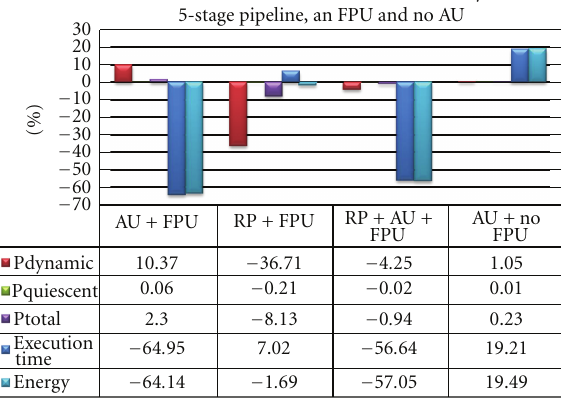
Table 14: NCC power and energy consumption.